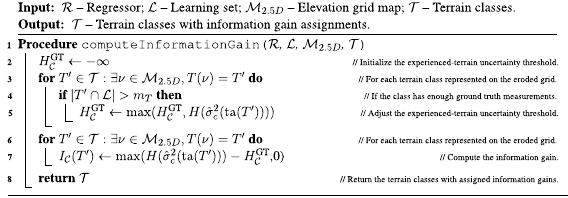
Algorithm 8. Compute information